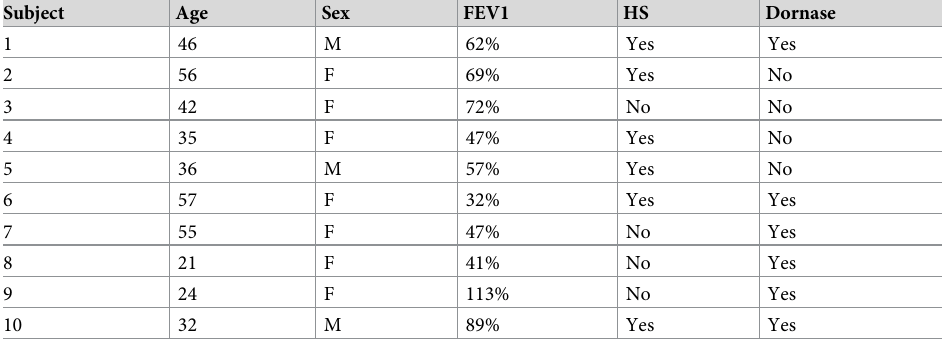
Table 1. Subject